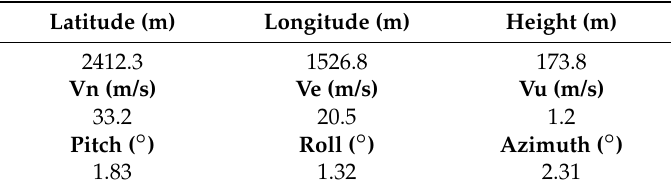
Table 4. RMS of navigation errors for conventional INS with MTi-G in static mode.